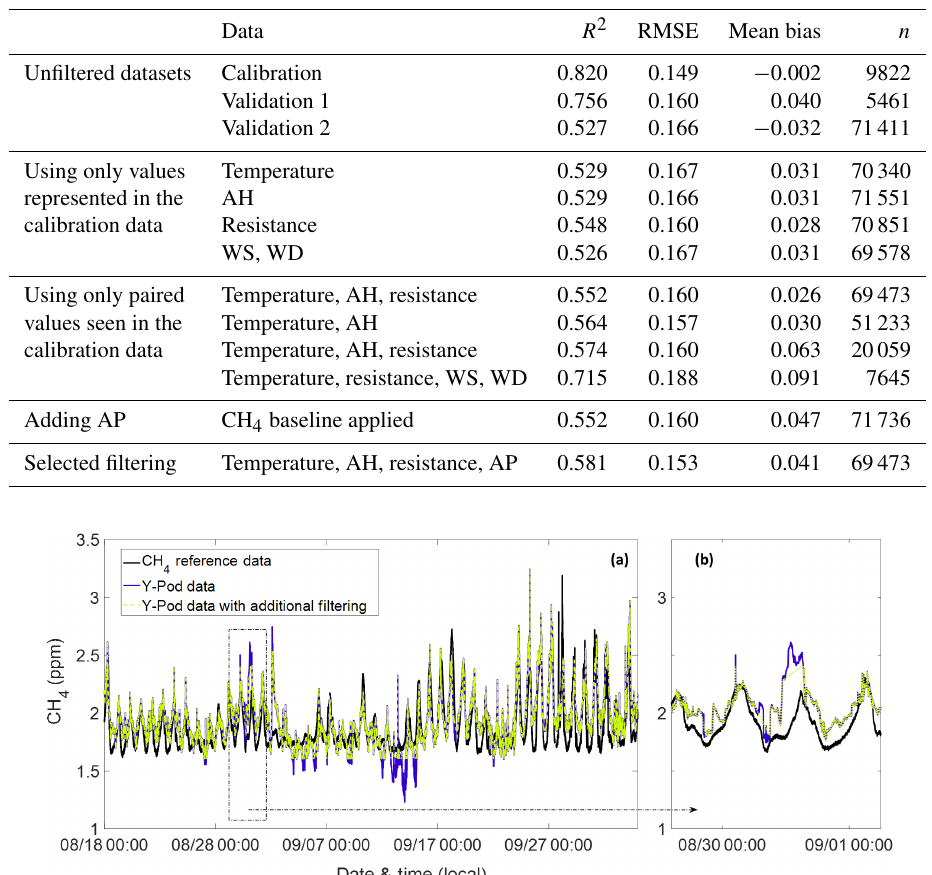
Table 5. Additional filtering to improve calibration model performance on field data. AH is absolute humidity, WS is wind speed, WD is wind direction, and AP is atmospheric principles.